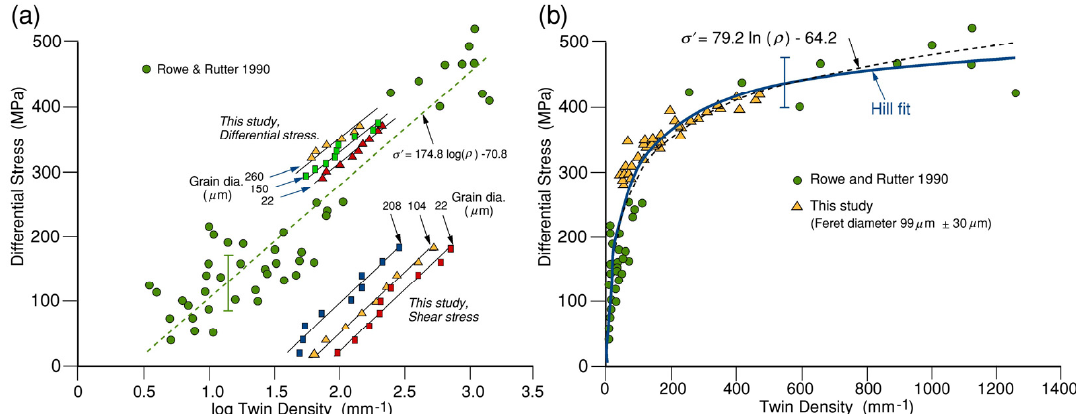
Figure 14. ( a ) Data of Rowe and Rutter [6] relating differential stress to log twin density for three calcite rocks. These data are compared with those from this study, shown as Gaussian smoothed differential stress data for three different grain size bands fitted to log twin density by multiple linear regression. Also shown are fits to smoothed resolved shear stress data (using the same stress scale), again for three grain size bands; ( b ) Linear plot of differential stress against twin density for the data of Rowe and Rutter [6] plus the data of this study referred to the grain size band centred on the mean grain size. The data are fitted to the exponential function shown (dashed curve), but also fitted to the Hill equation (Equation (3)), constrained to pass through the origin (0, 0) (dark blue curve).